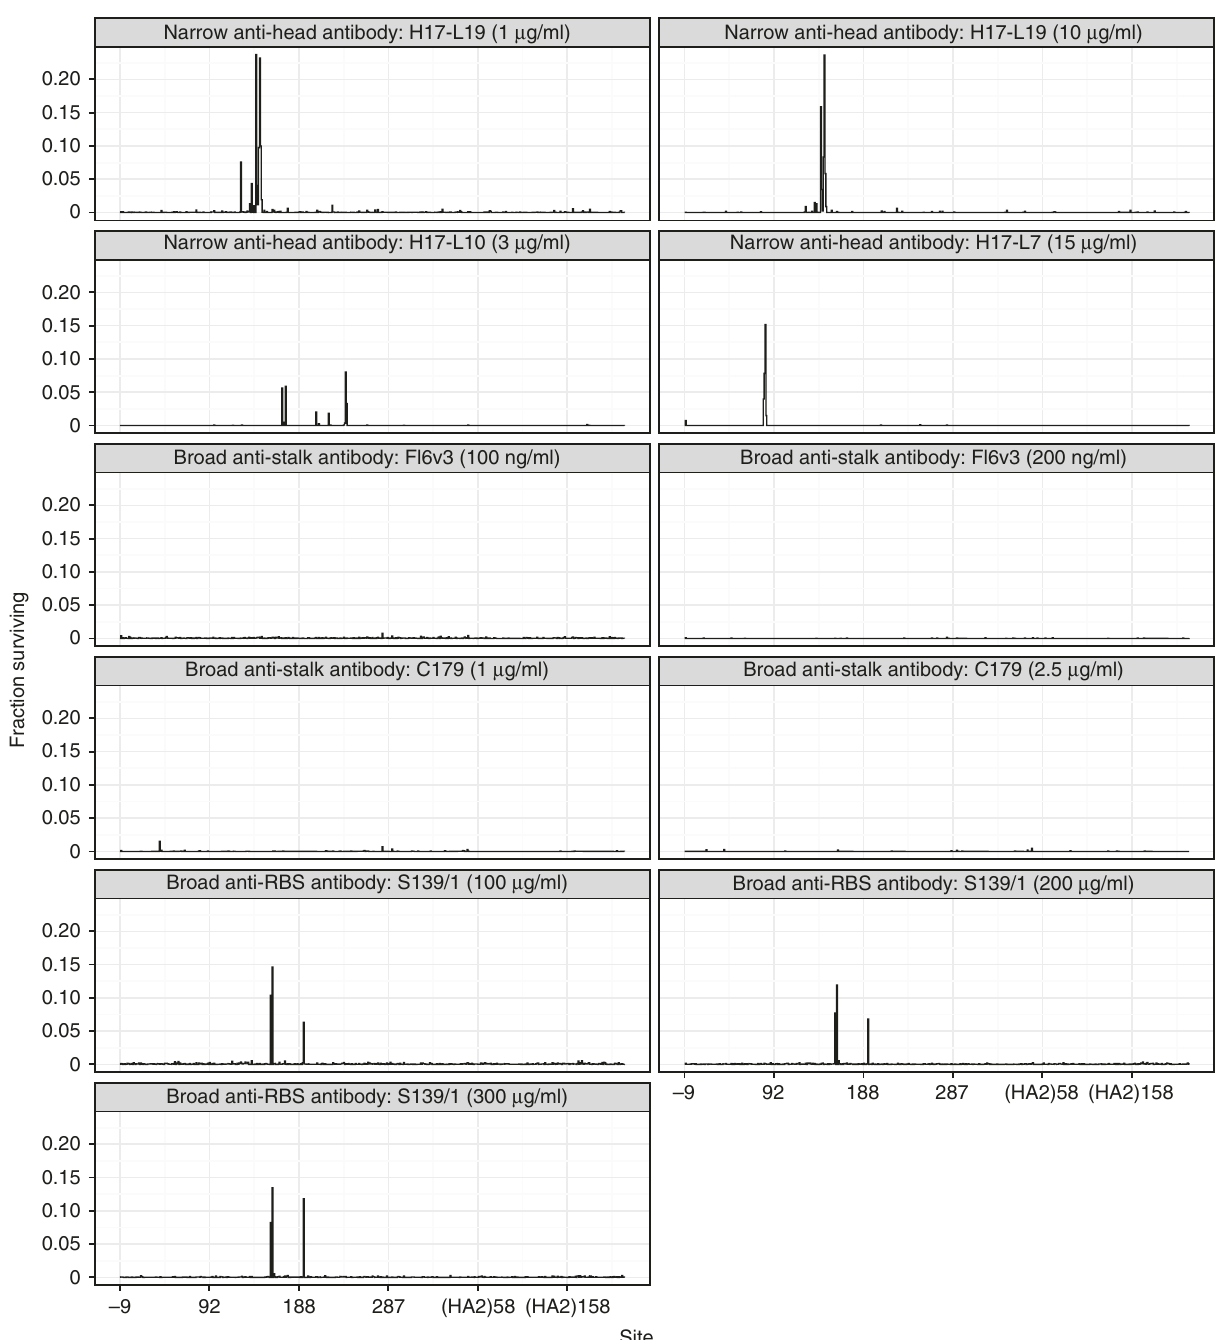
Fig. 4 Strain-speci fi c and anti-receptor-binding-site antibodies select mutations with large antigenic effects, but anti-stalk antibodies only select small- effect mutations. The excess fraction of virions with a mutation at each site that survive the antibody, averaging across all amino-acid mutations at each site (see Eq. 10). There are multiple sites of large-effect mutations for H17-L19, H17-L10, H17-L7, and S139/1, but none for FI6v3 and C179. Supplementary Fig. 2 shows the excess fraction surviving for the largest-effect mutation at each site. Supplementary Figs. 3, 4, 5, 6, 7, and 8. show all mutations using logo plots. Sites are labeled in H3 the possible amino-acid mutations from a given codon, whereas codon mutations access all possible amino-acid mutations. The correlations among replicates of the mutational antigenic pro fi ling, in terms of the measured fraction-surviving above average for each possible amino-acid mutation, are shown in Supplementary Fig. 1. For the remainder of this paper, we will refer to the median antigenic effect of each mutation across replicates.